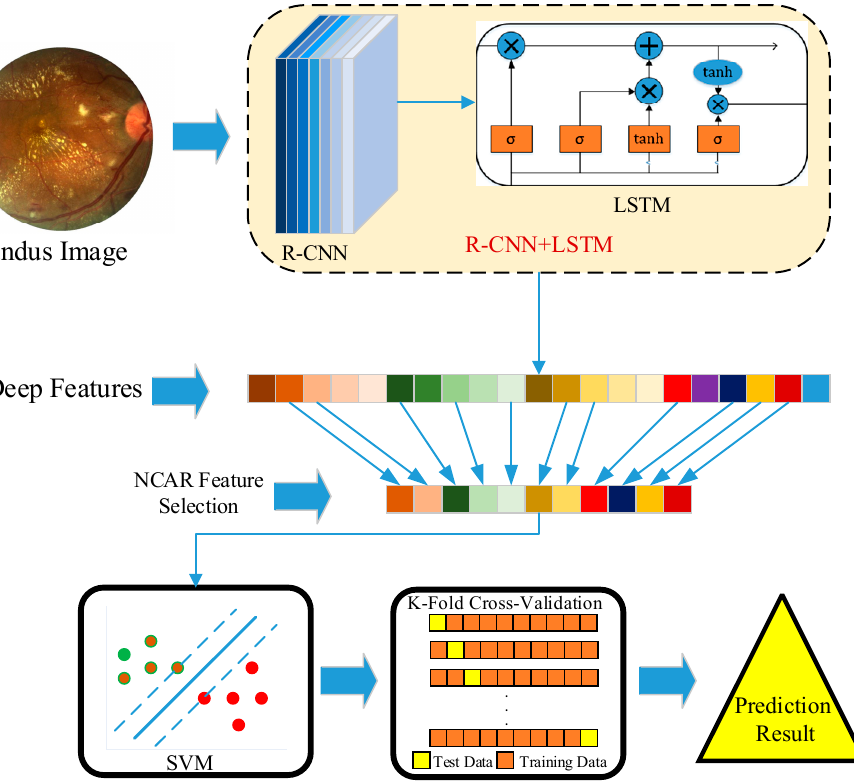
Figure 1. Framework of the proposed approach.